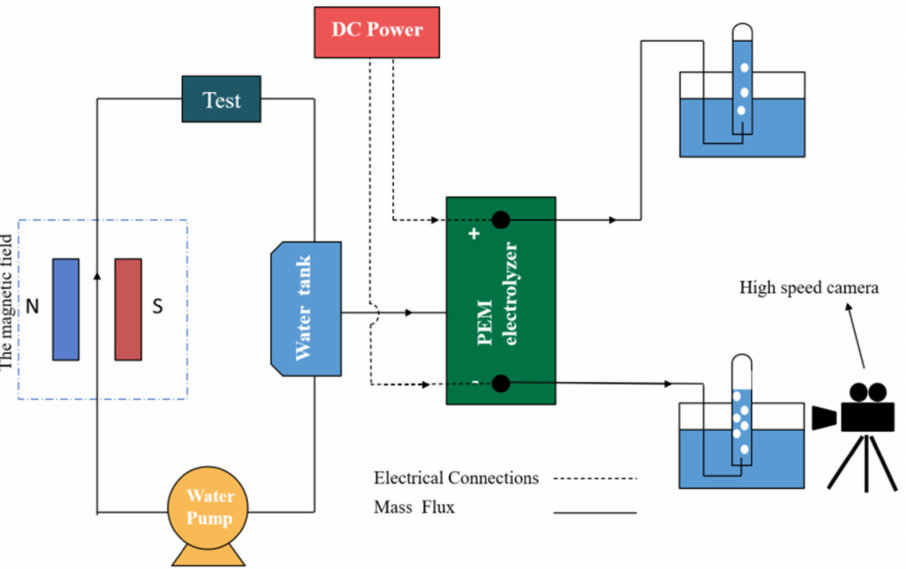
Figure 3. Schematic diagram of low-power electrolytic hydrogen production experimental device based on strong magnetic